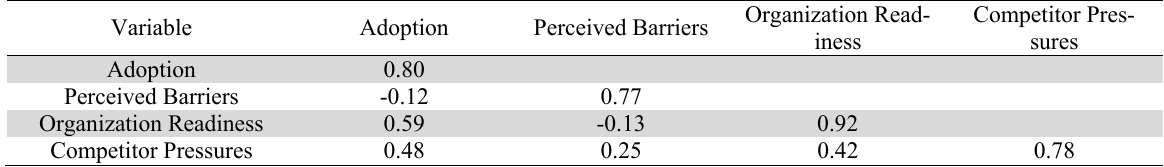
Discriminant Validity for Small